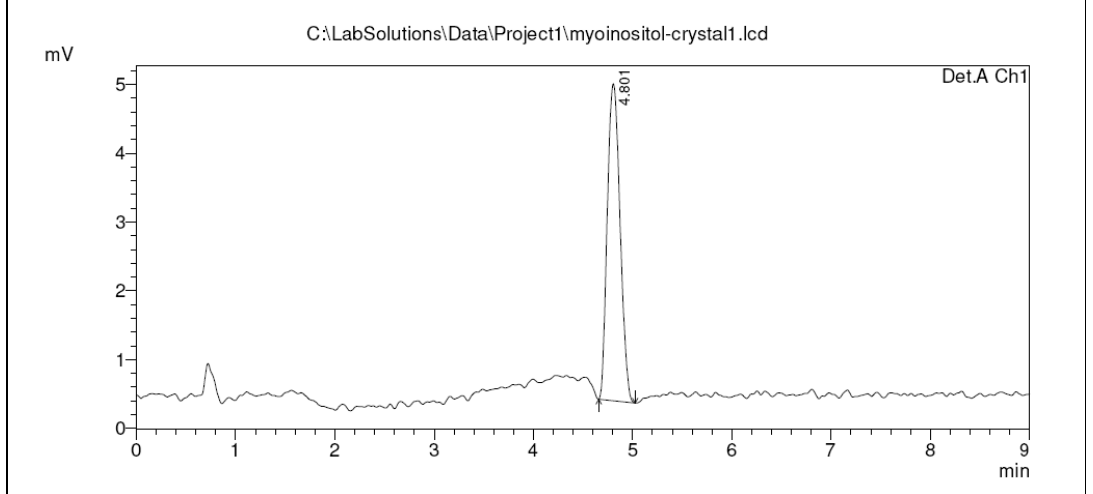
Figure 4. Crystal purity check using HPLC where the peak and retention time of the myo -inositol sample was observed at 4.8